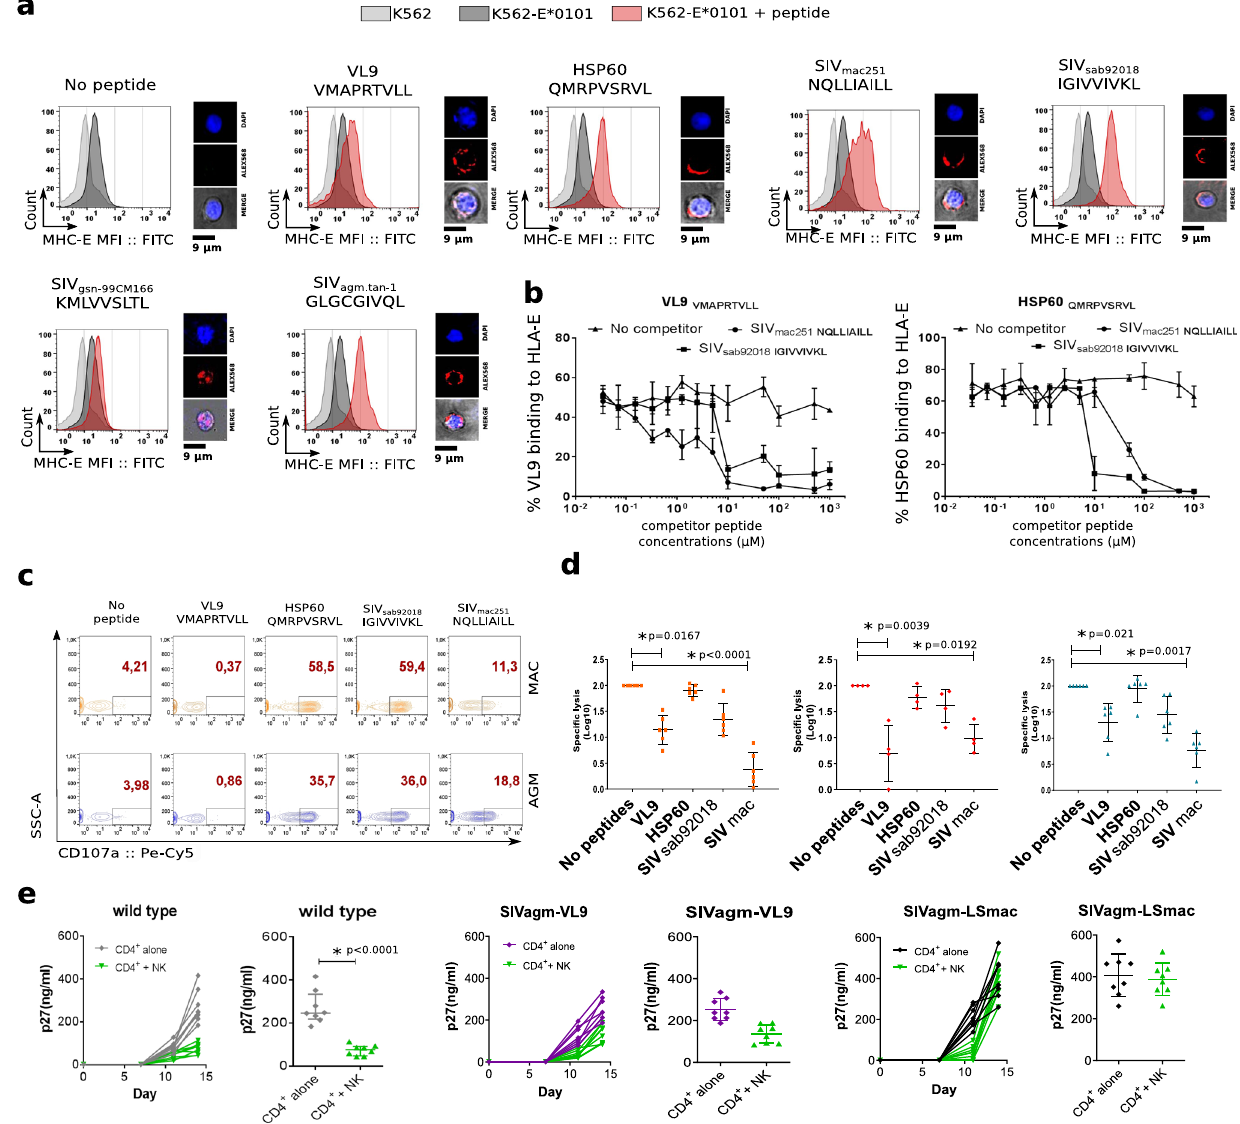
Fig. 7 Analysis of MHC-E restricted NK cell activity. a Each histogram shows HLA-E expression after loading K562-E*0101 cells with the different peptides. Light gray curves indicate the mean fl uorescent intensity (MFI) of HLA-E on K562 cells (control), the dark gray curves the MFI of HLA-E on K562-E*0101 cells without peptides, and the red curves the MFI of HLA-E on K562-E*0101 cells loaded with the given peptide. VL9 and HSP60 are control peptides well known to bind to MHC-E and deriving respectively from HLA-I and heat-shock protein. The SIVmac251 and SIVmac239 peptide sequences were identical. One representative experiment out of more than three is shown. On the right side are shown the localization of the peptide stained with Alexa 568 (red). Nuclei were stained with DAPI (blue). b Competition assay for binding to HLA-E. K562-E*0101 cells were loaded with biotin-A2 VL9 (left) or HSP60 peptides (right). An increasing concentration of the indicated unlabeled competitor peptides were introduced into the culture. HLA-E-bound biotinylated peptide was measured at the cell surface. line represent the median of three independent experiments. Error bars represents the range. c Analysis of HLA-E dependent activity of NK in presence of K562-E*0101 cells loaded or not with peptides. Activity was evaluated by CD107a cell surface expression. Dot plots show representative examples for one animal per species. d HLA-E dependent activity of NK cells from blood of six uninfected cynomolgus MAC (orange squares), four uninfected rhesus MAC (red circles) and six uninfected AGM (blue triangles) in the absence or presence of peptides, as indicated. The black line indicates the median and error bars the interquartile range. Each symbols represents a unique monkey. For Groups comparisons two-sided Wilcoxon signed-rank test with Bonferroni correction were used ( n = 5). P values of less or equal to 0.05 were considered statistically signi fi cant. Asterix indicate signi fi cant change when compared to the base line. Exact P values are provide on the graphs. e SIV suppressive capacity of autologous NK cells depending on the ENV nonamer sequence in the infectious virus. The panels show in vitro replication levels of SIVagm. sab92018 (gray), SIVagm.sab92018 mutant with the sequence coding for the VL9 peptide (purple) and the SIVagm.sab92018 mutant with the sequence coding for the SIVmac nonamer peptide (black) in primary CD4 + T cells from 8 uninfected AGM cultured alone or in presence of autologous NK cells (green). For each of the three viruses, left panels show longitudinal viral replication pattern (days 0, 7, 11 and 15 p.i.) and right panels viral replication at the end time-point of the culture (day 15 p.i.). The y -axis reports viral replication level as quanti fi ed by SIV p27. The black line indicates the median and error bars the interquartile range. Signi fi cant difference between the two conditions was determind using using two-tail Mann – Whitney per experiment. Asterix indicate a statistically signi fi cant difference. The exact P value is